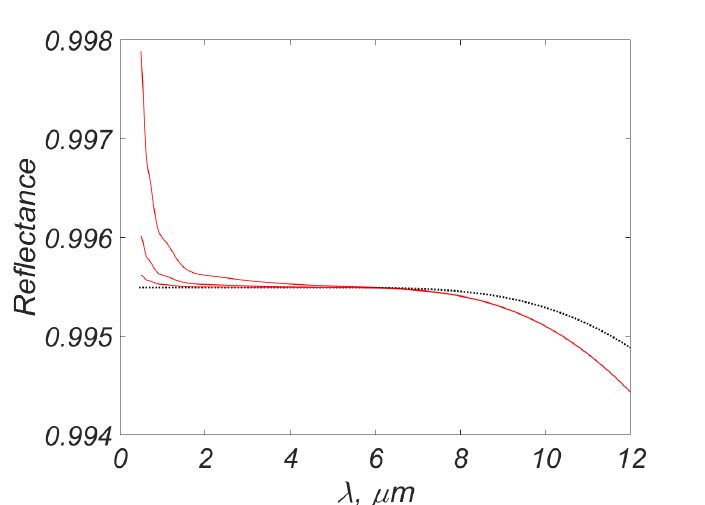
Figure 6. Fabry–Perot interferometer. The reflection spectrum for the case of s -polarization. Notations correspond to Figure